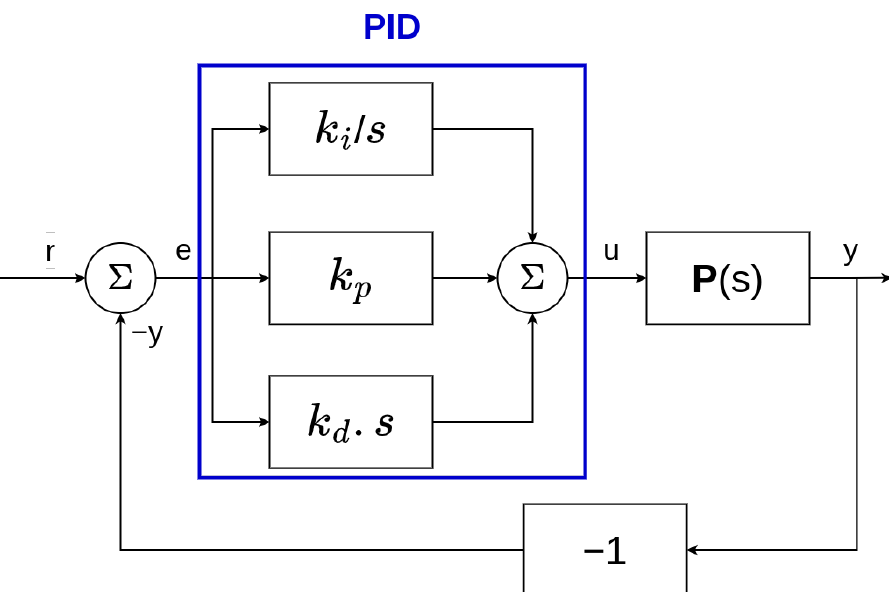
Figure 2. The block diagram of a feedback system composed of a PID controller and a plant